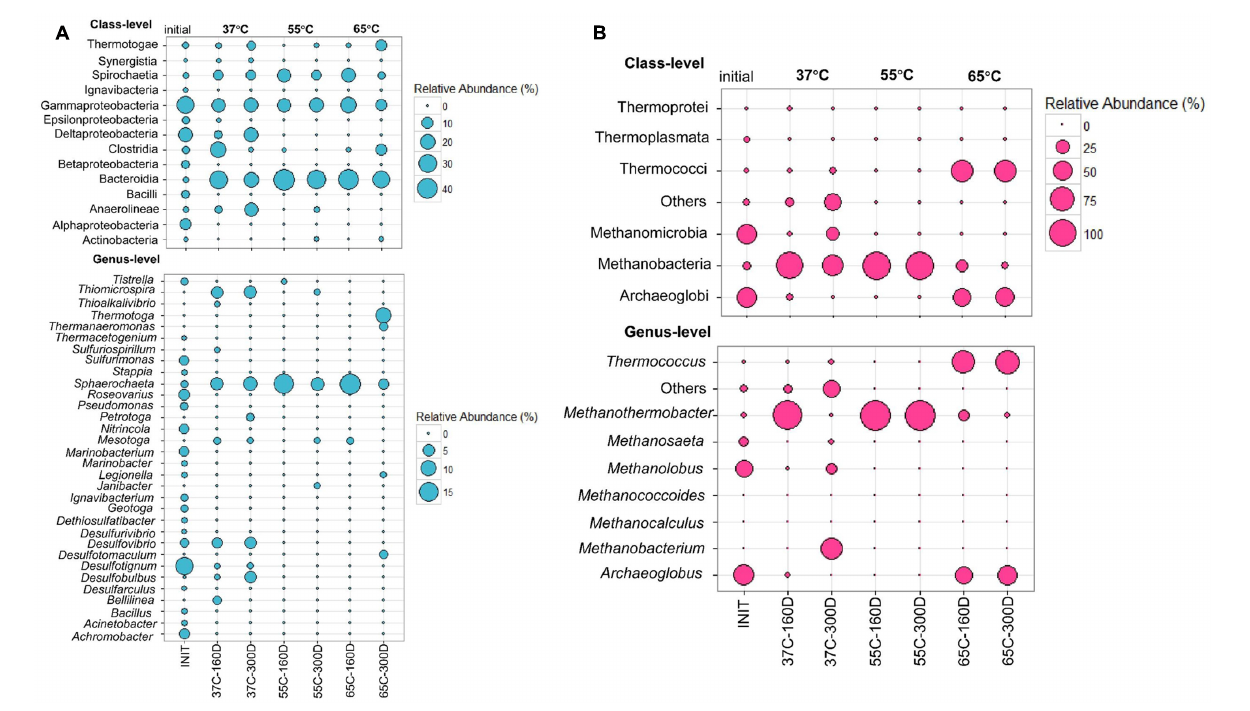
FIGURE 4 | Bubble plots showing the relative abundance > 0.5% of bacterial (A) and archaeal communities (B) in at least one sample at the class and genera levels. Abundance less than 0.5% of the total composition in all libraries are defined as “others.” INIT represents initial production water of petroleum reservoir, for details see Li et al. (2017a); 37C-160D means microcosms incubated at 37 ◦ C after 160 days; 37C-300D means microcosms incubated at 37 ◦ C after 300 days, and so